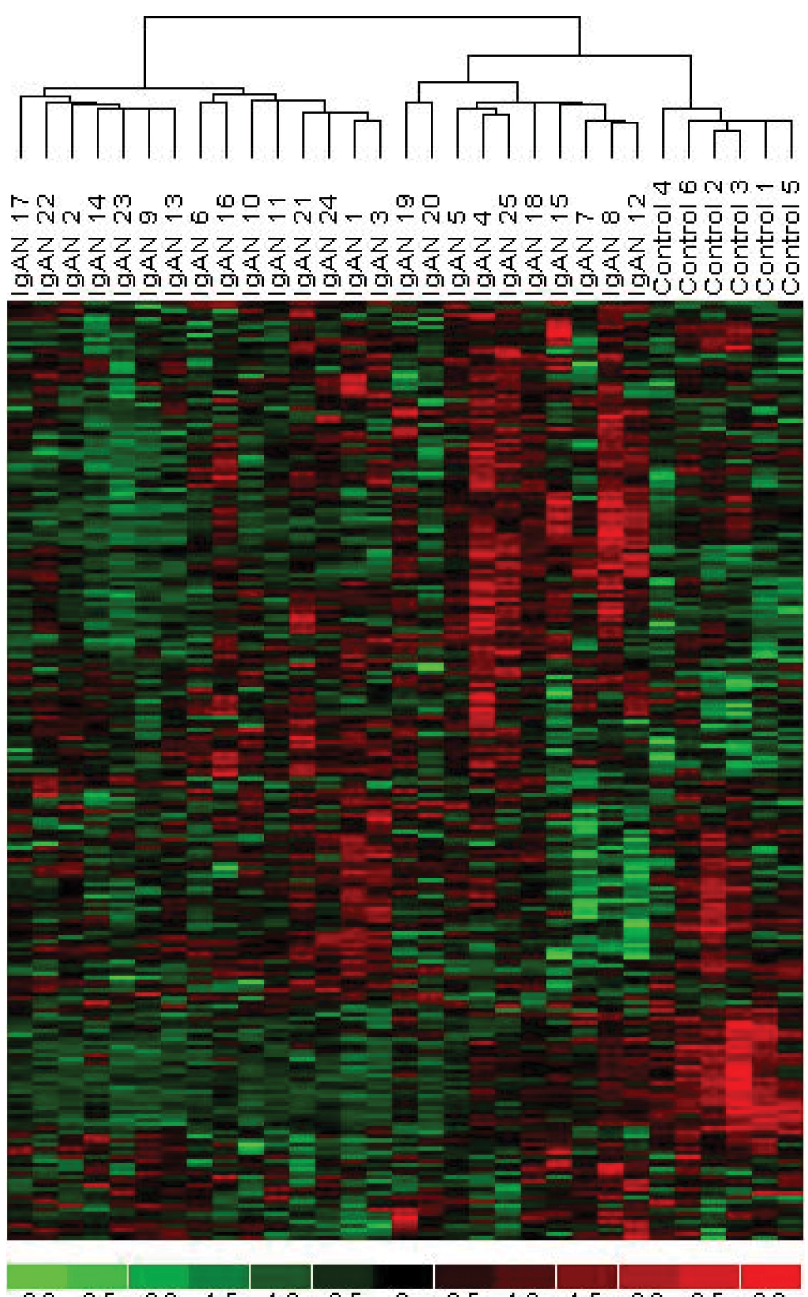
Figure 1. Cluster analysis. Clustering of microarrays according to disease status (horizontal axis) based upon expression of the 231 albumin- regulated genes (vertical axis). Control=control group, IgAN=IgA